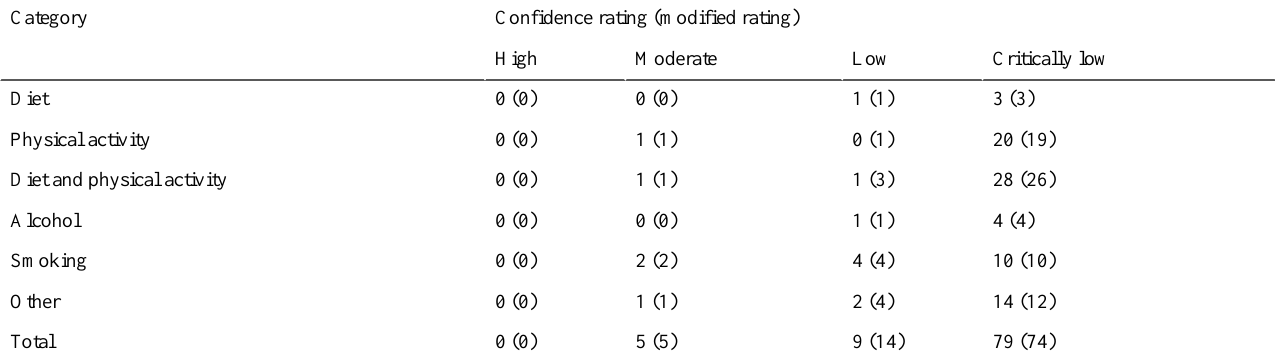
Table 1. Risk of bias: a summary of AMSTAR-2 confidence